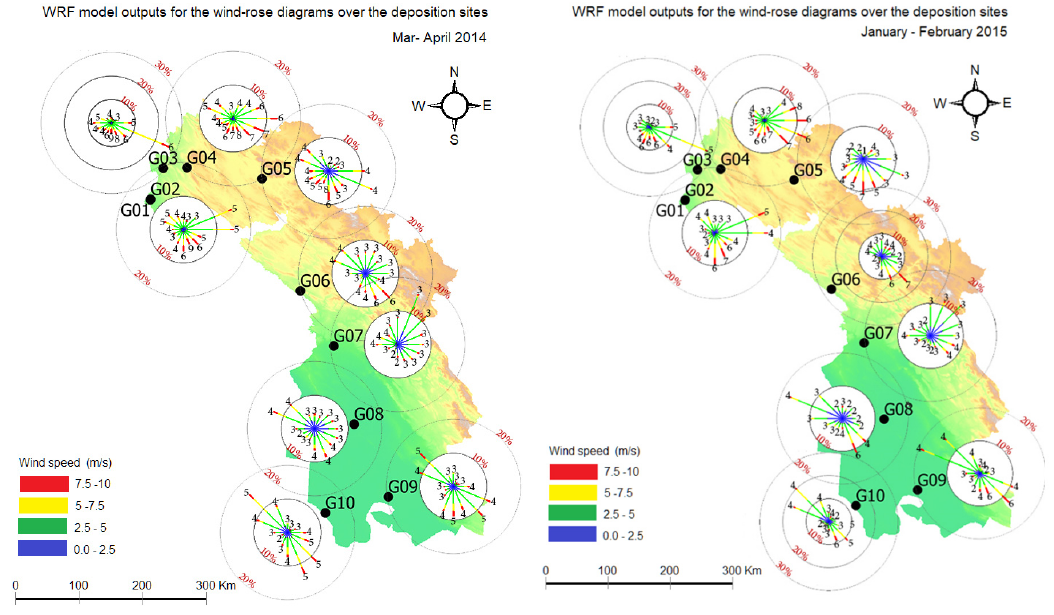
Figure 7. WRF model outputs for the wind rose diagrams.